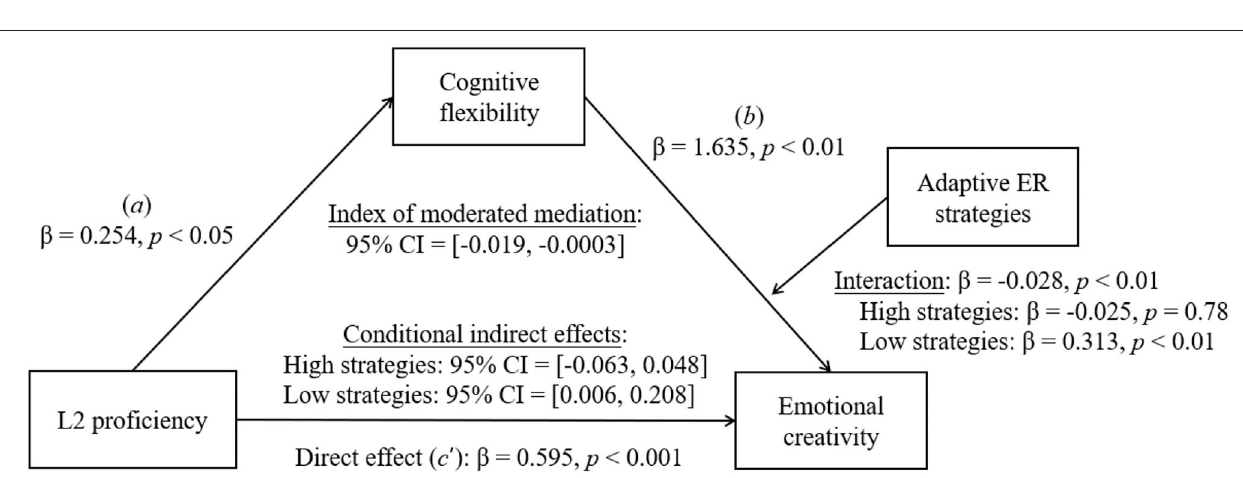
FIGURE 5 | Moderated mediation roles of cognitive flexibility and adaptive ER strategies in bilinguals’ EC. The depicted is the path diagram of moderated mediation analysis showing both the direct and the indirect effect of L2 proficiency on bilinguals’ EC. Statistical results were satisfied for a moderated mediation effect: Path a , Path b , and Path c’ were all significant. The adaptive ER strategies had a moderation effect on Path b when their use was at a low level ( − 1 SD